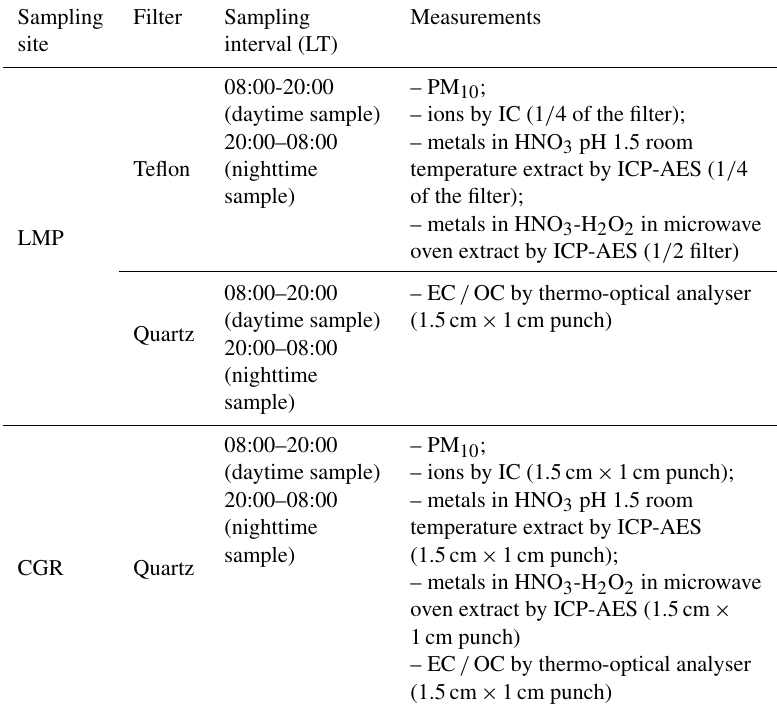
Table 1. Sampling strategy and chemical measurements carried out on each filter for the two sites: Lampedusa (LMP) and Capo Grani- tola (CGR). The sampling time interval is at local time